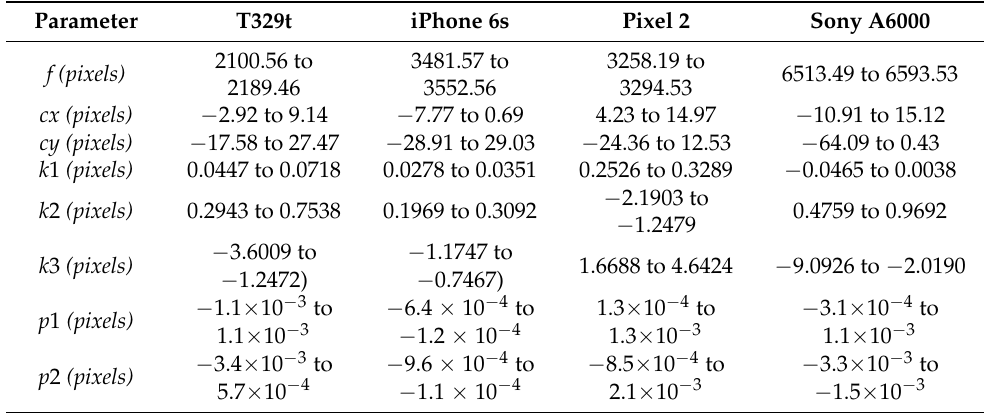
Table 3. The calibrated parameters of the smartphone cameras and the mirrorless camera with different image